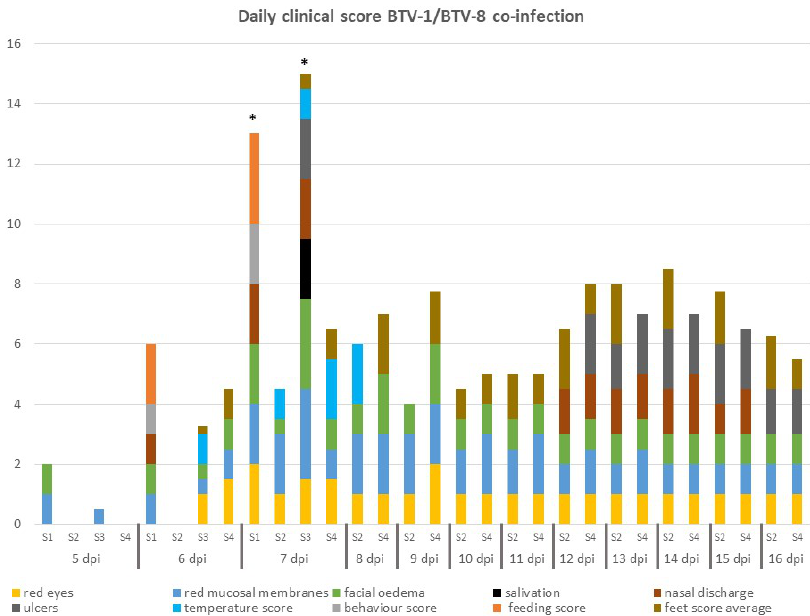
Figure 3. Daily clinical score of sheep co-infected with two BTV strains. The daily cumulative score